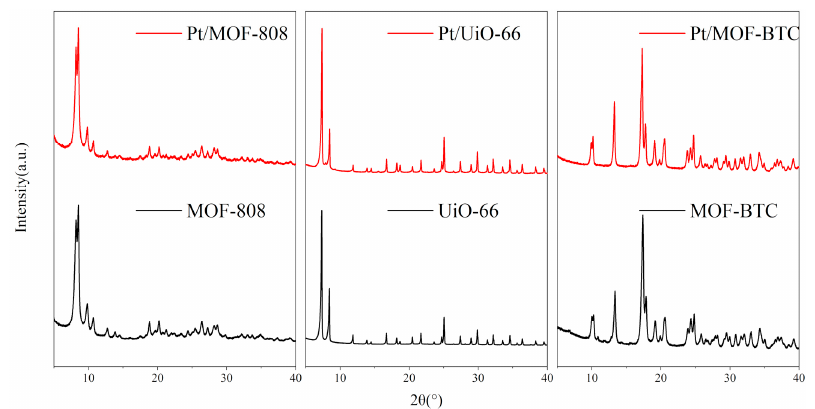
Figure 1. The XRD patterns of different catalysts.